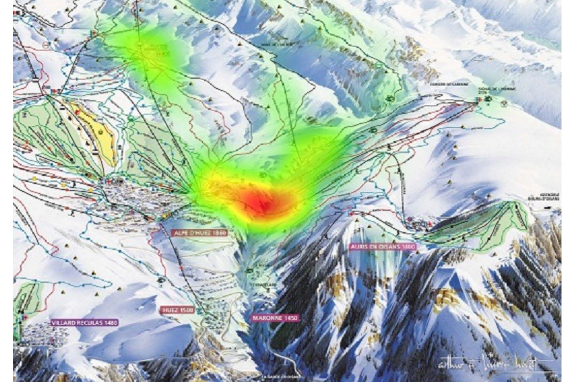
Figure 10 Excerpts of Heatmap and Verbatim from the crossing area between Alpes d’Huez and Auris en Oisans.